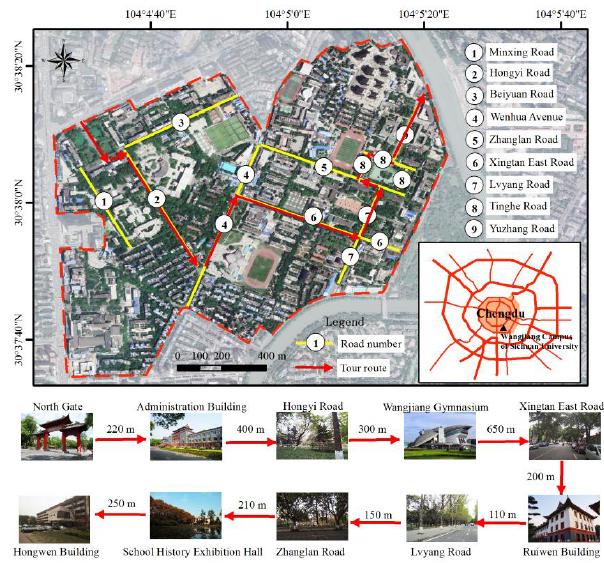
Figure 13. Optimal path planning of campus tourism.